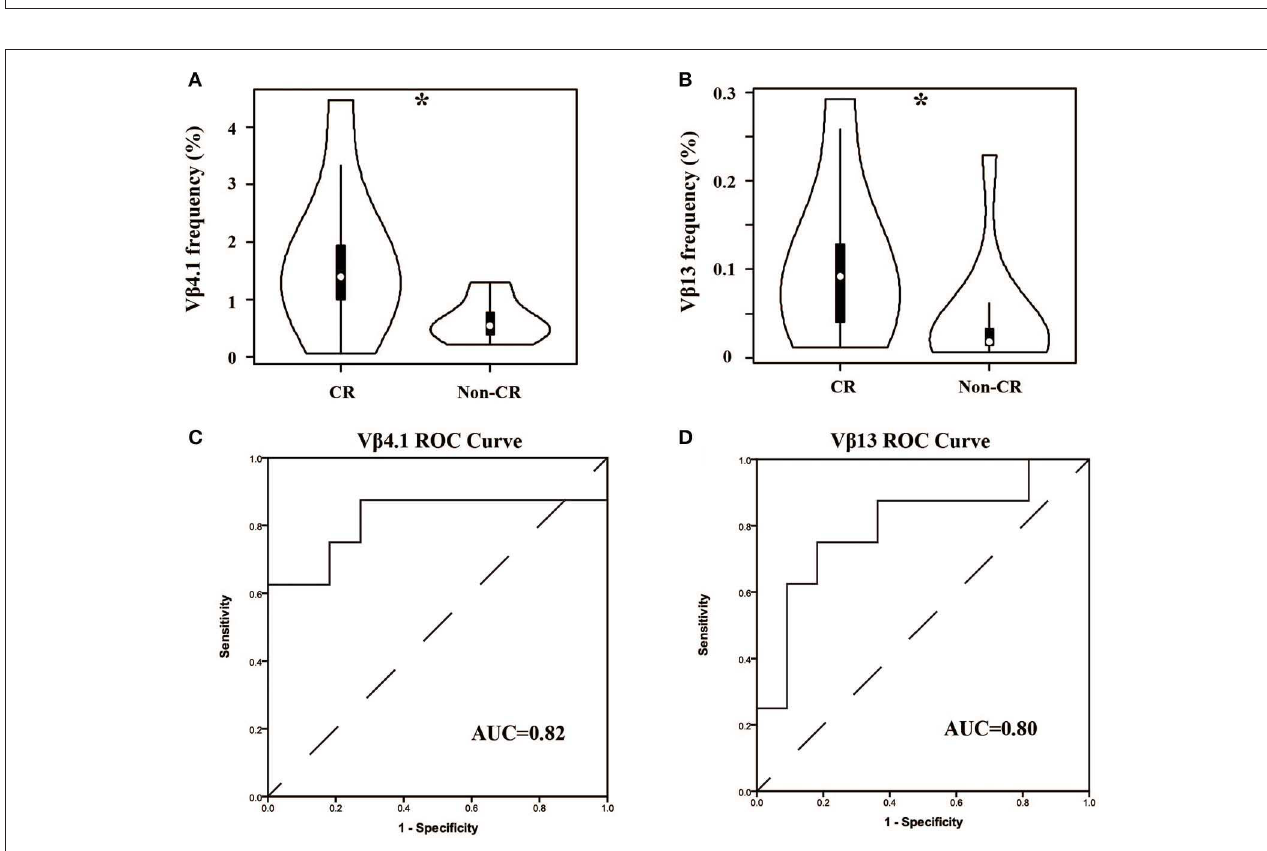
FIGURE 5 | Comparison of V β 4.1 and V β 13 gene segments used in patients with or without urinary protein after 6-months therapy. (A,B) The usage frequencies of V β 4.1 and V β 13 gene segments in CR group and non-CR group. (C,D) ROC analysis for the frequencies of V β 4.1 and V β 13 gene segments in MN patients to separate the two groups. * P <